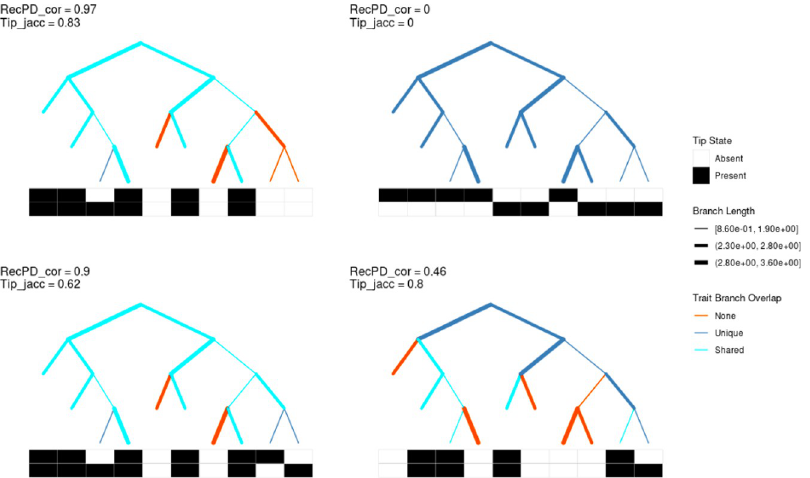
Fig 5. RecPDcor identifies correlated gene-family distributions missed by tip Jaccard similarity. Top panels– Distributions of two features (black = present, white = absent) arrayed against a species tree. RecPDcor and tip Jaccard similarities both identify correlated and anti-correlated gene families. Bottom panels–Distributions where RecPDcor reveals correlated gene family distributions where tip Jaccard does not, and where tip Jaccard overestimates correlation of gene families with distinct evolutionary histories. Tree topologies are represented as cladograms with branches of equal length; actual branch-lengths are indicated by branch-thickness as indicated in the legend. Branches are assigned to different categories based on the overlap of their RecPD-inferred gene family lineages: Shared —branches where both traits are present (teal); 2) Unique— branches where only a single trait is present (blue); None –branches where both traits are absent